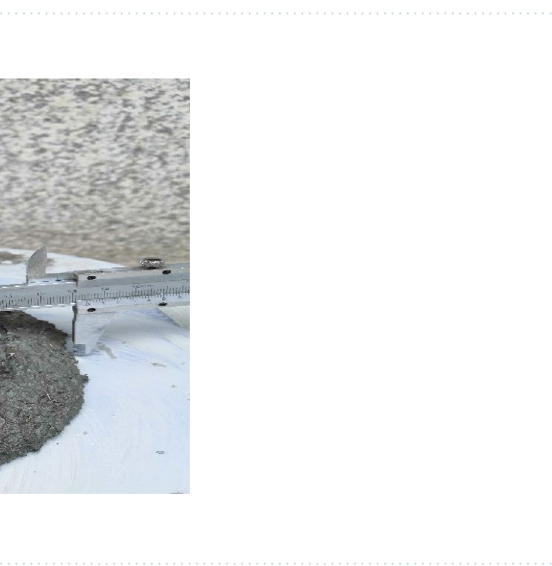
Table 3. Levels of experimental factors, given in actual and code values.